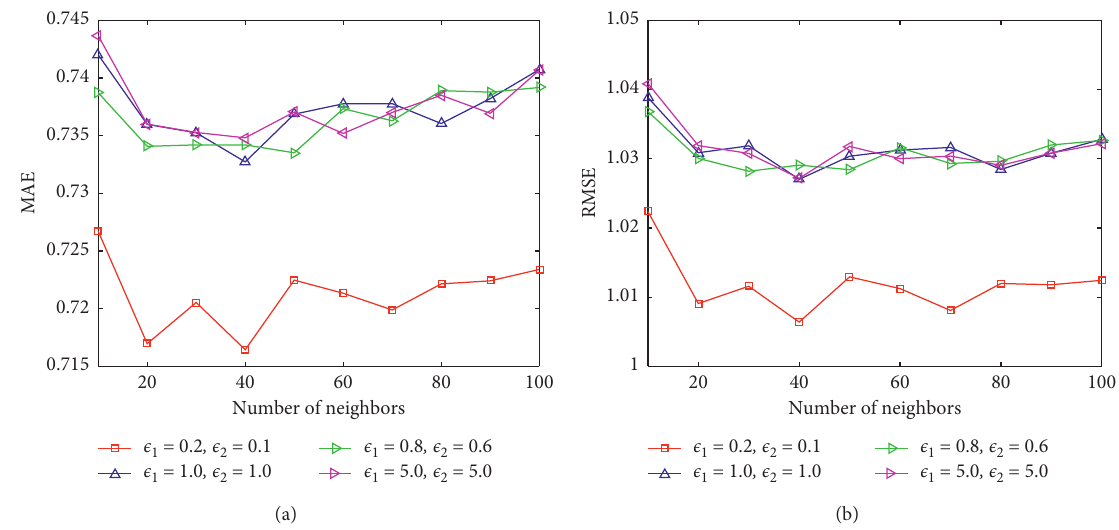
Figure 4: Movielens. (a) MAE results between different values of ε